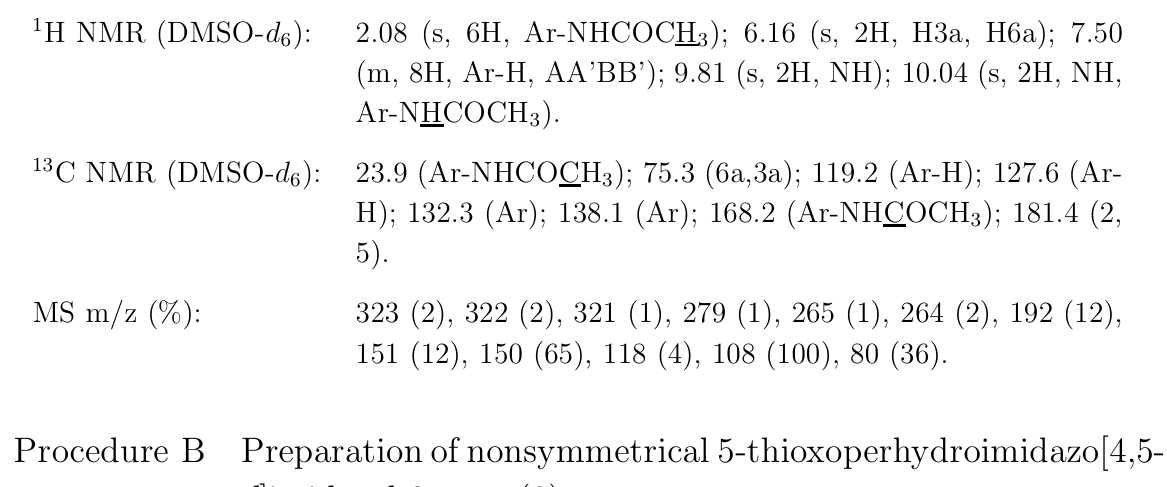
Preparation of nonsymmetrical 5-thioxoperhydroimidazo[4,5- d ]imidazol-2-ones